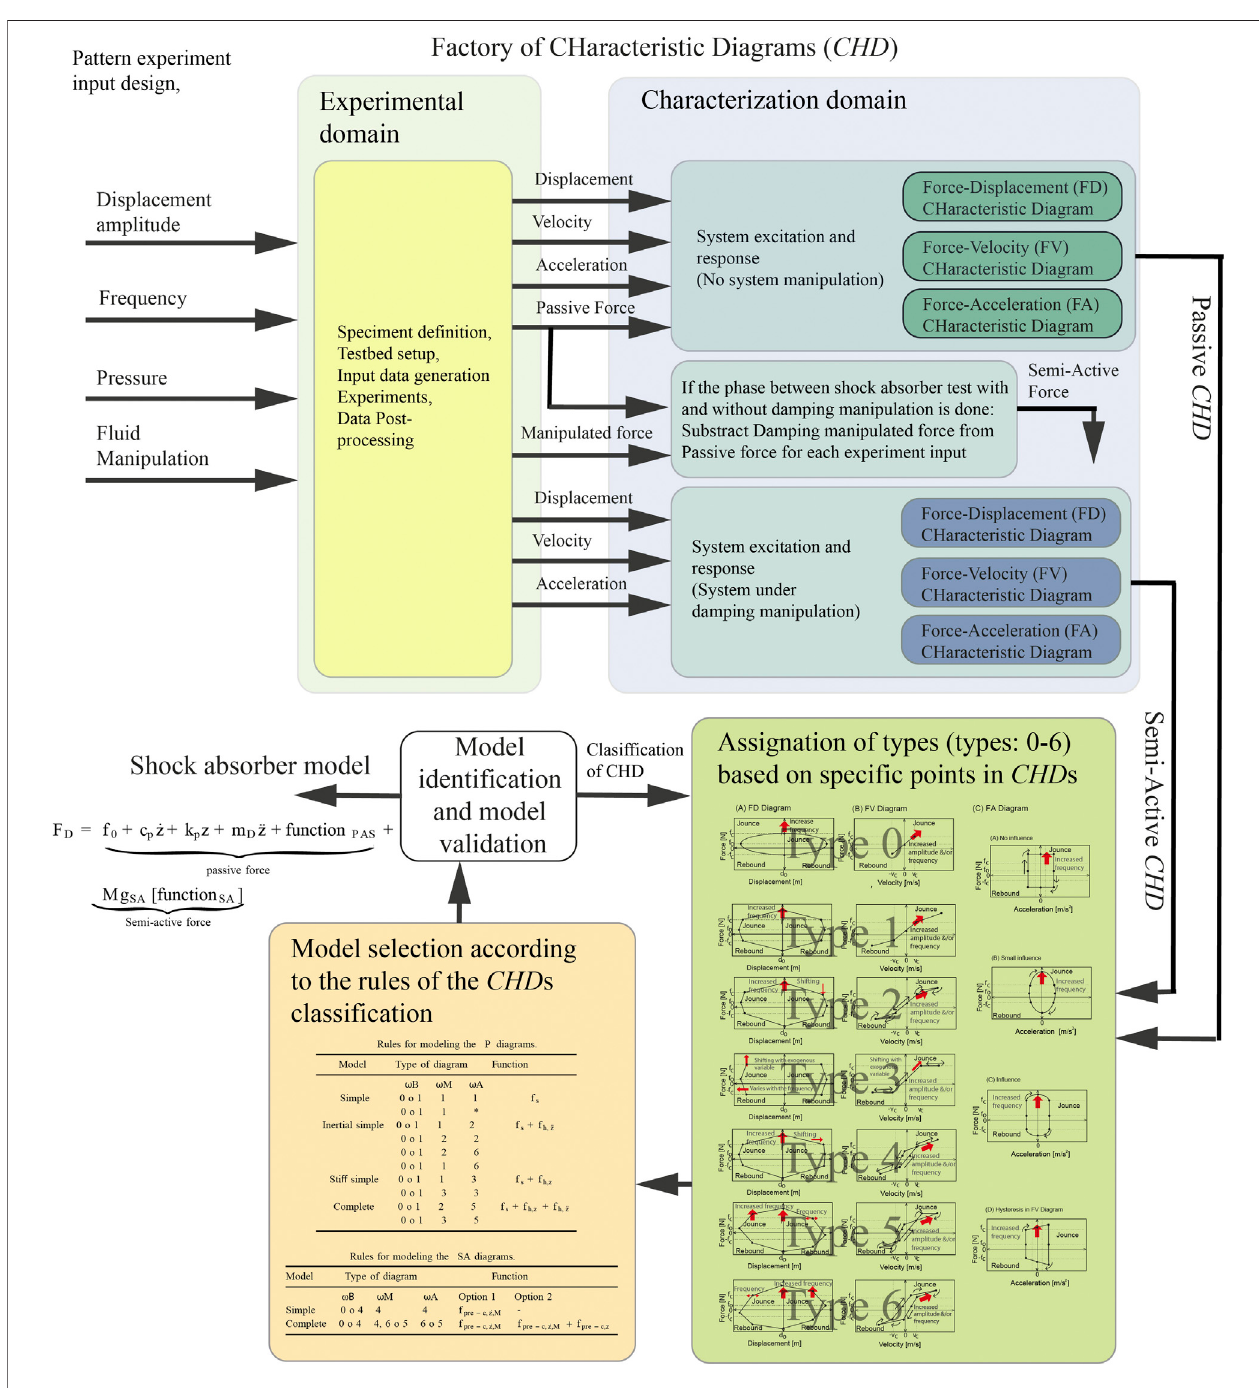
FIGURE 11 | Block diagram describing the generation of characteristic diagrams from experimental data. For details on the Model identi fi cation and model validation(white)blockoutputseetheequationsin Section3 .ThetablesinsidetheblockModelselectionaccordingtotherulesofCHDsclassi fi cationare Tables9 and 10 . Regarding the block Assignation of types (types: 0 – 6) based on speci fi c points in CHDs see Section 2 and Figures 3 – 9 .